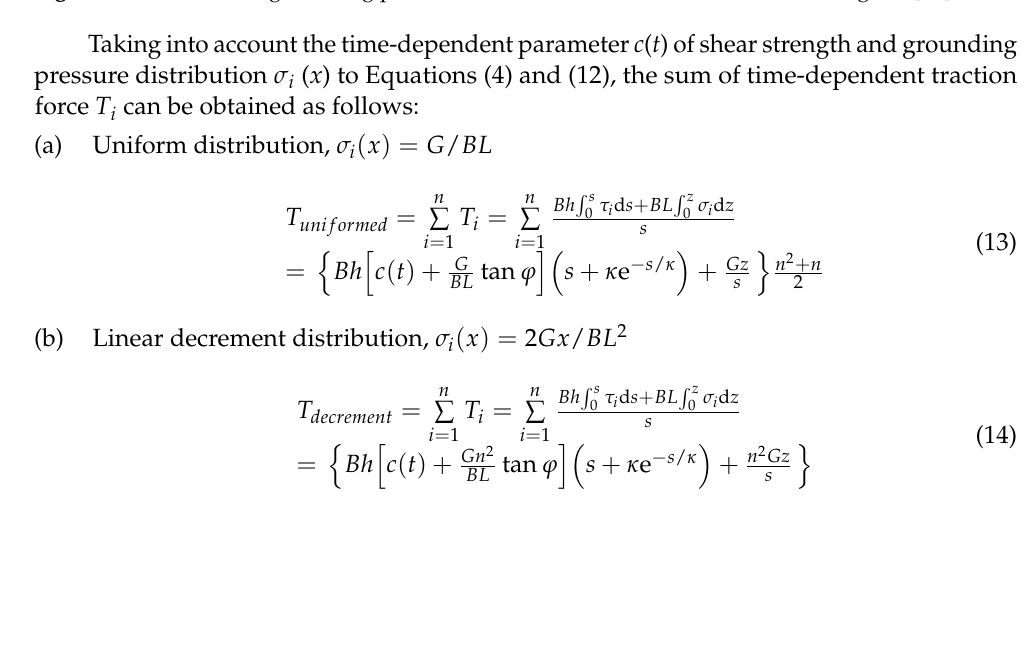
Figure 9. Four kinds of grounding pressure distribution under the crawler with length L